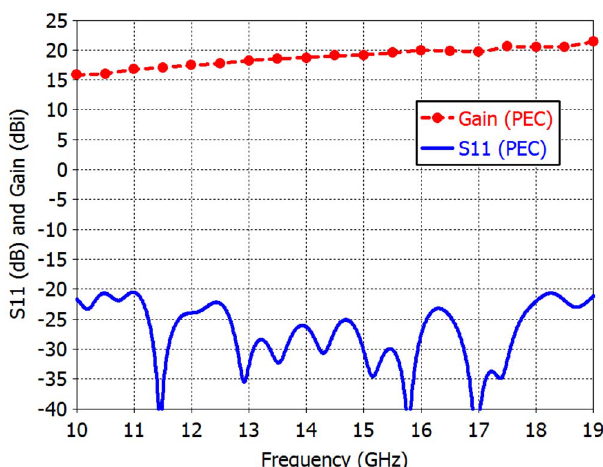
Figure 2: The simulation results of the designed antenna with PEC material for S 11 (reflection coefficient) and realized gain.